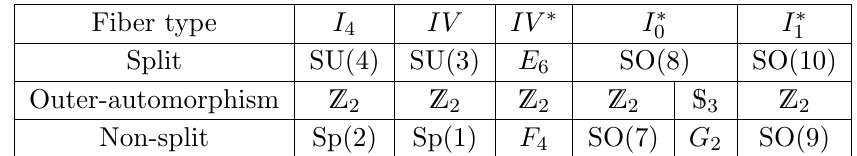
p (cid:0) (cid:1) 3 (cid:0) i ( (cid:0) g ) 4 = 3 p (cid:0) (cid:1) 1 + i 3 g